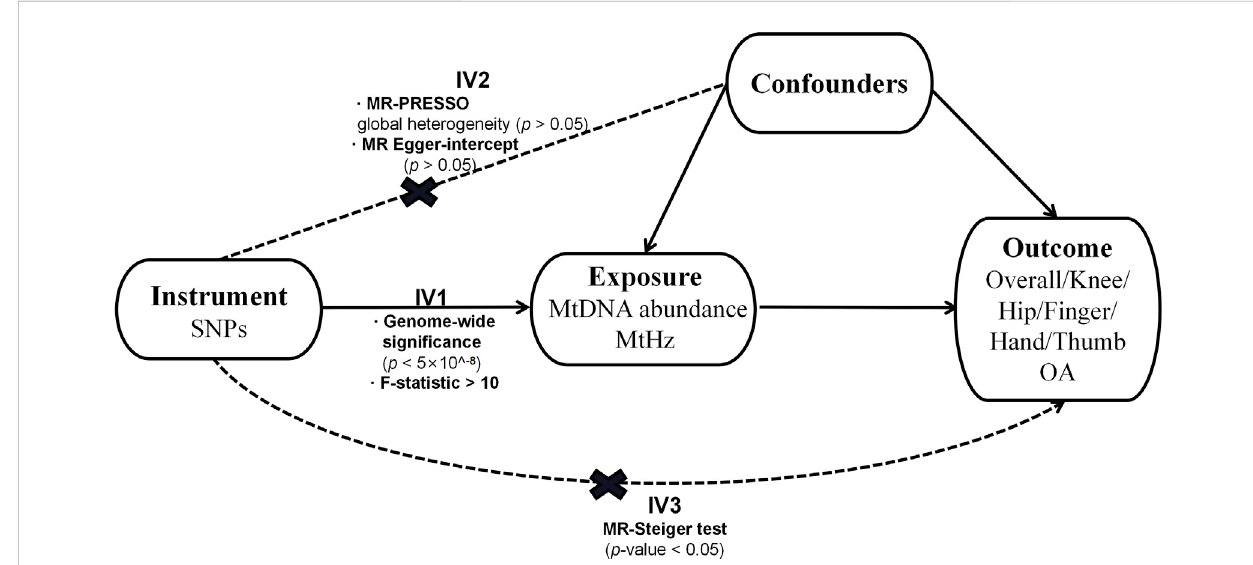
FIGURE 1 The assumptions of MR and how we tested these assumptions in our